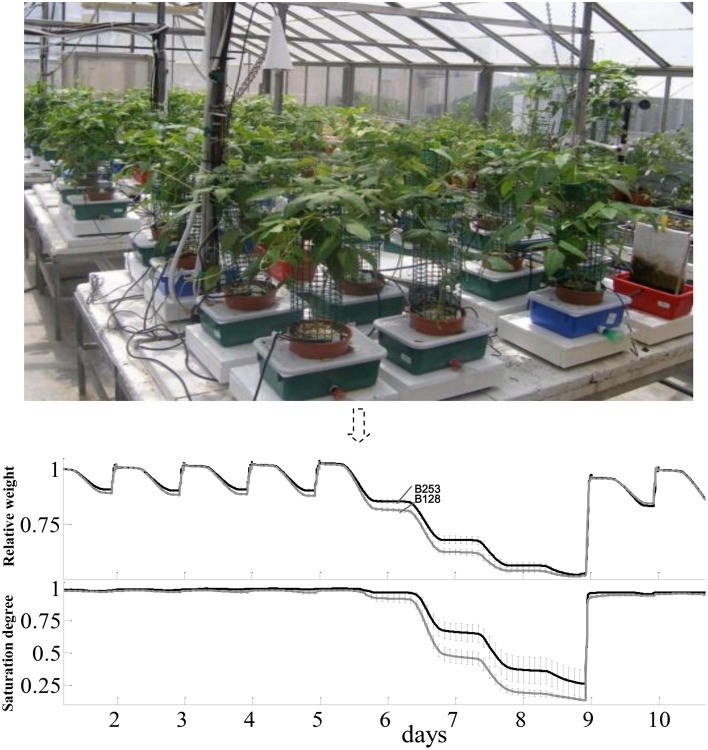
The lysimetric system and a general description of full physiological profiling experiment. The lysimetric system (top panel) constituted greenhouse array loaded with asparagus bean plants. This fully automated system collects data from all of the plants simultaneously. The pot-container system set on a sensitive, temperature-compensated load cell. A soil probe in each pot continuously monitors the volumetric water content and electrical conductivity of the growth media. The irrigation system is controlled by pre-programmed valves (CPV). In the bottom panel, data shown were the mean and SE of weight variation in different tested lines. Only data of B253 (black line) and B128 (gray line) were put in the figure throughout the full-irrigation and drought to make the figure clear.